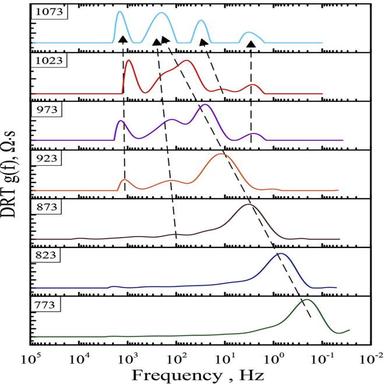
Frequency dependencies of the distribution of relaxation times (DRT) as calculated from the measured impedance spectra at different temperatures.